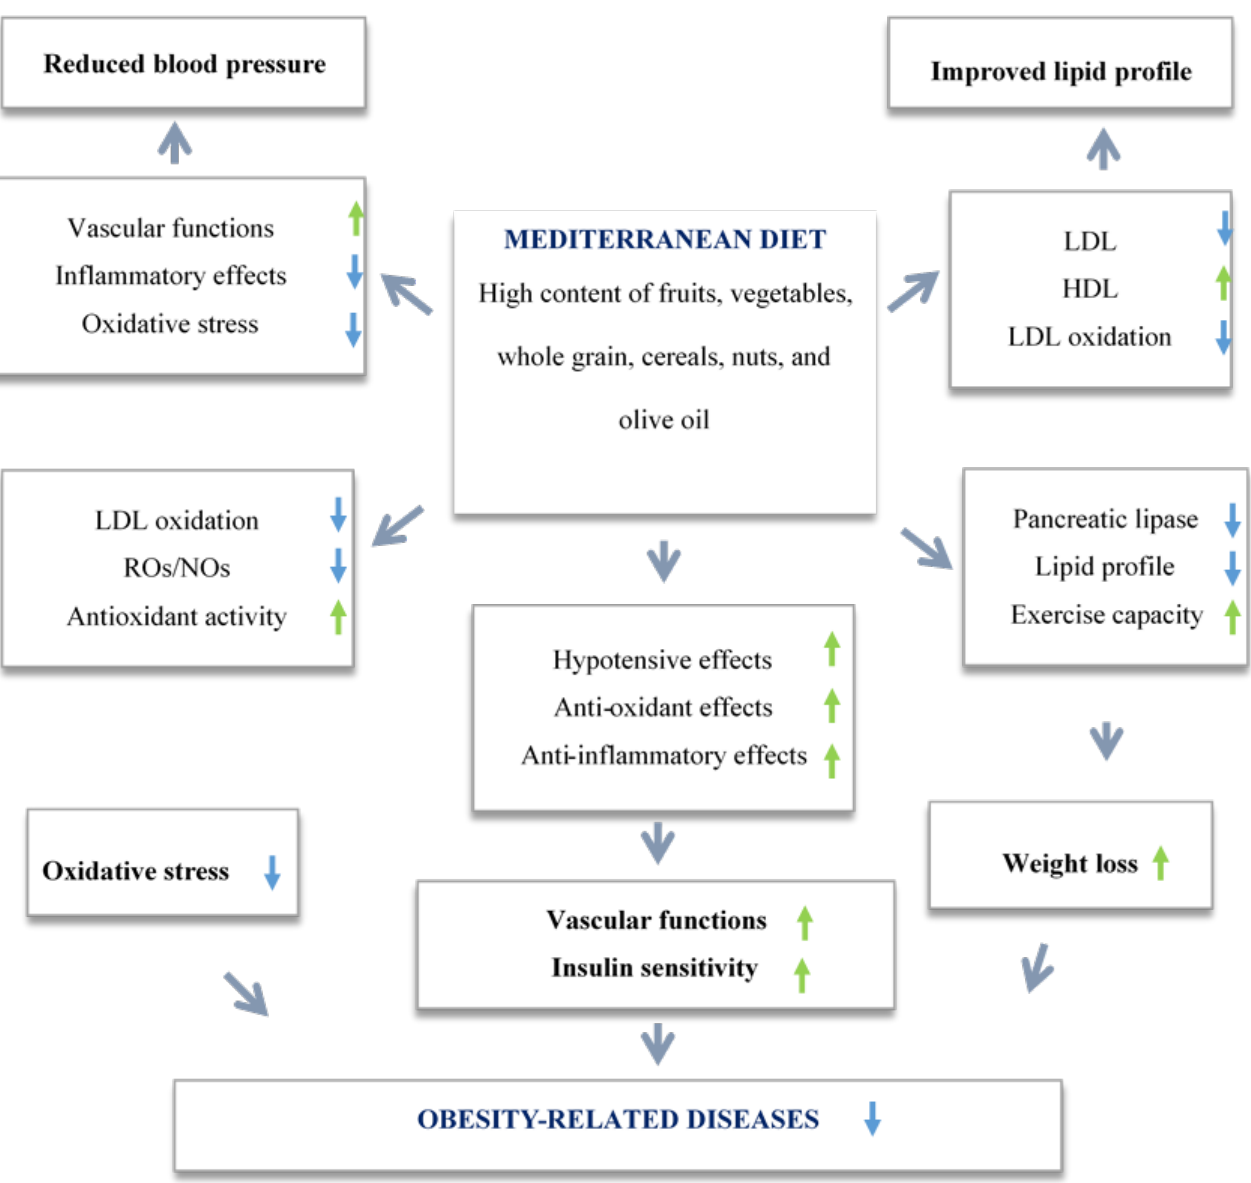
Figure 5. Cardiovascular beneficial effects of the traditional Mediterranean diet.